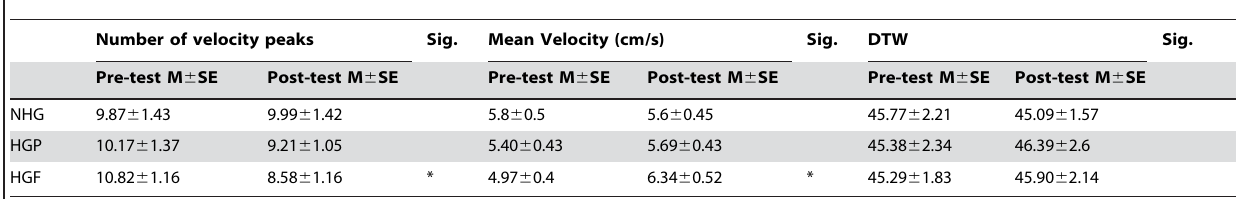
Table 1. Summary of raw data of Experiment 1 (mean 6 SE).